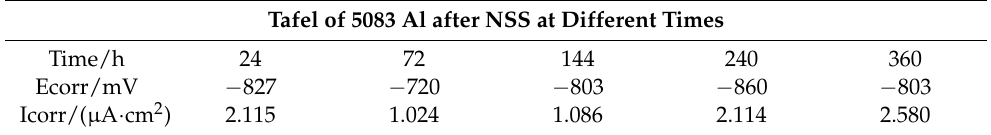
Table 4. Tafel of Al 2 O 3 3D/5083 Al after NSS at different time.